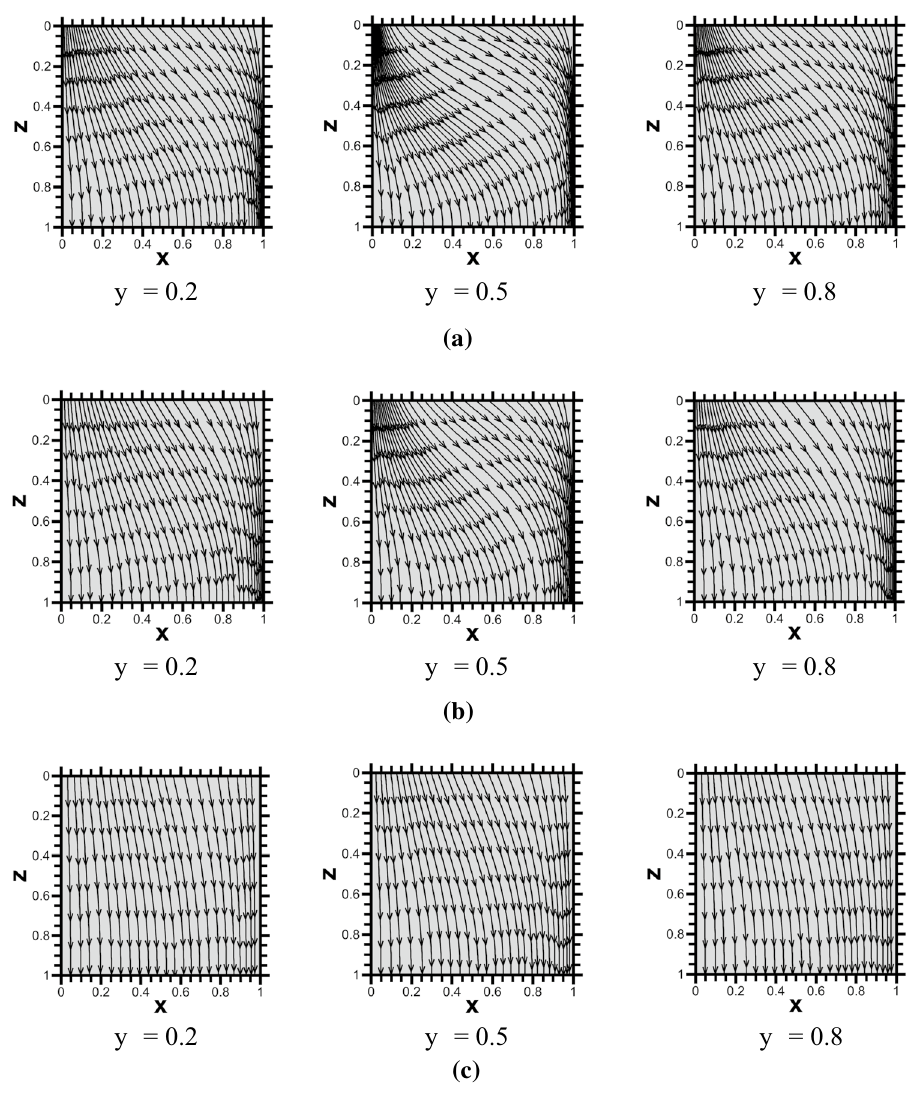
Fig. 19 A sample of the stream lines in the plan for pass- ing plates through the depth 𝜐 ( = 0.25), a t = 0.05, b t = 0.1, c t =